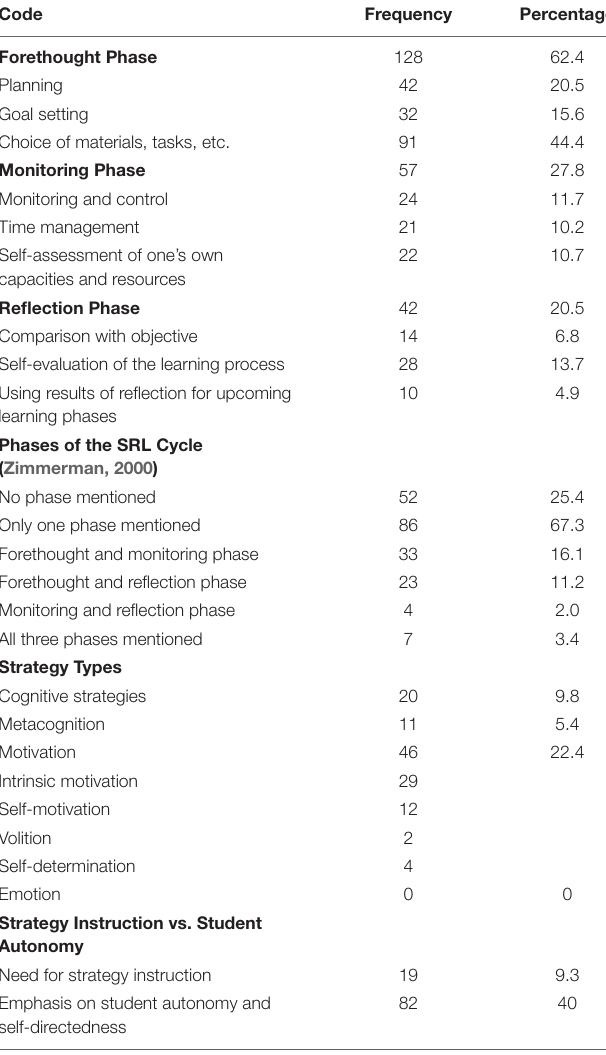
TABLE 3 | Frequencies of codes for teacher utterances about defining